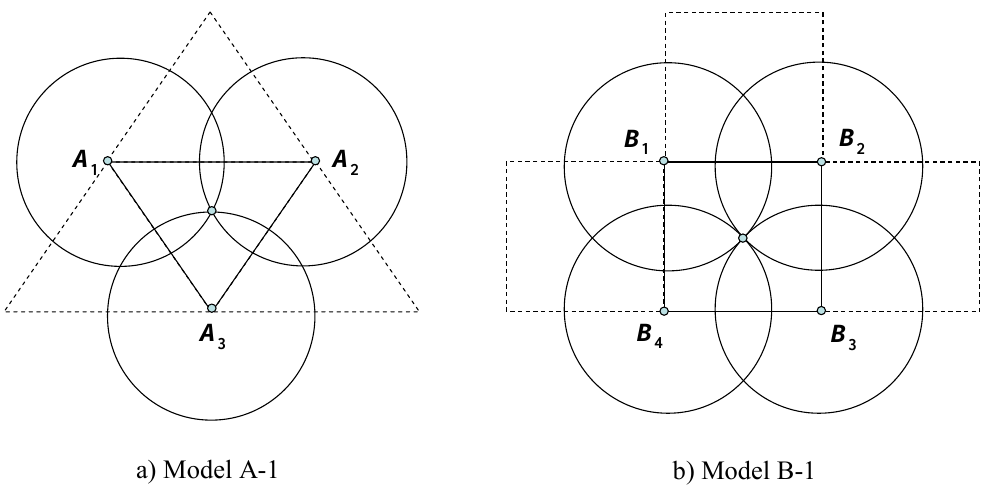
Figure 1. Coverage with uniform sensing